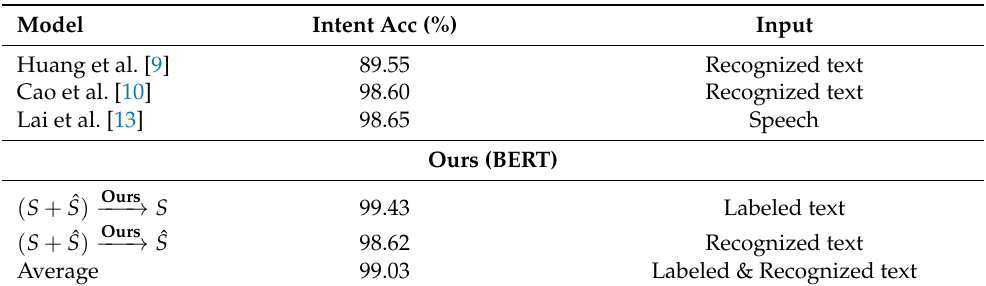
Table 5. Intent classification performances of comparative models and ours in the Audio-Snips dataset